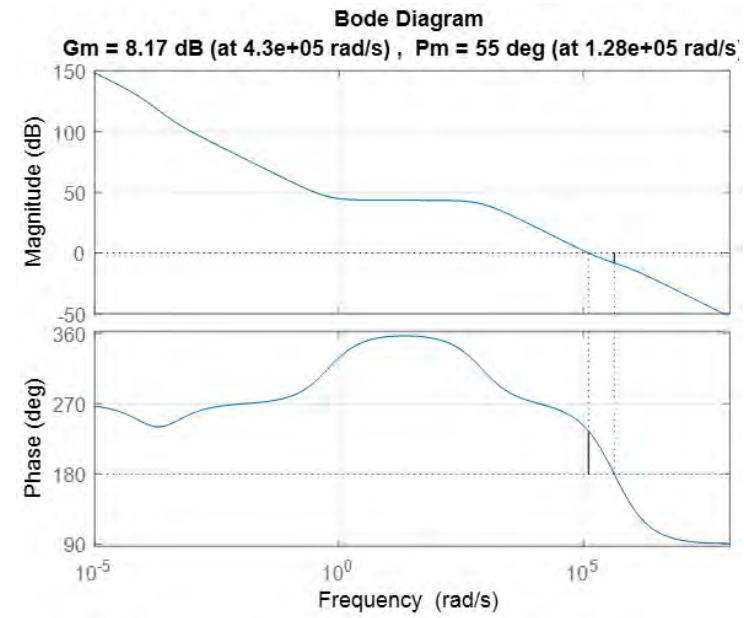
Figure 10. Bode plot of the open loop controlled output voltage transfer function